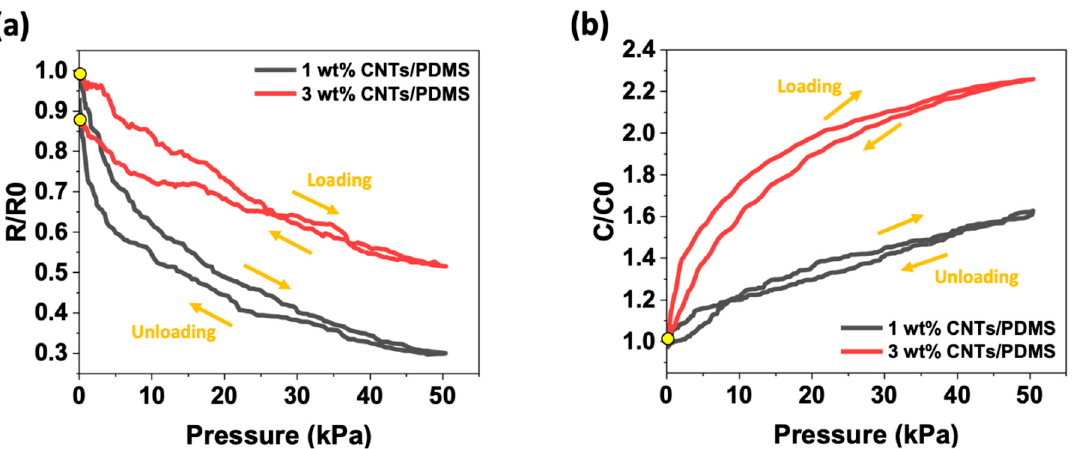
Figure 6. Normalized change in ( a ) resistance ( R / R 0 ) and ( b ) capacitance ( C / C 0 ) with hysteresis cycle of 50 kPa for 1 wt% and 3 wt% CNT/PDMS composites.